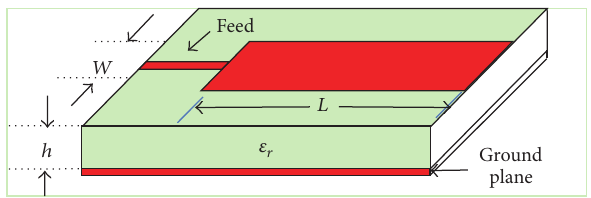
Figure 1: Rectangular microstrip